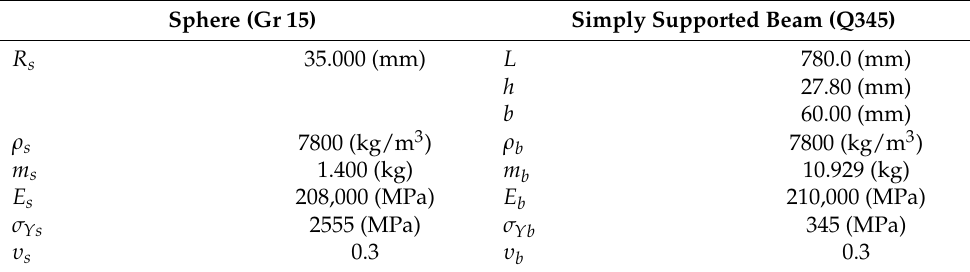
Table 2. Material properties and geometry.